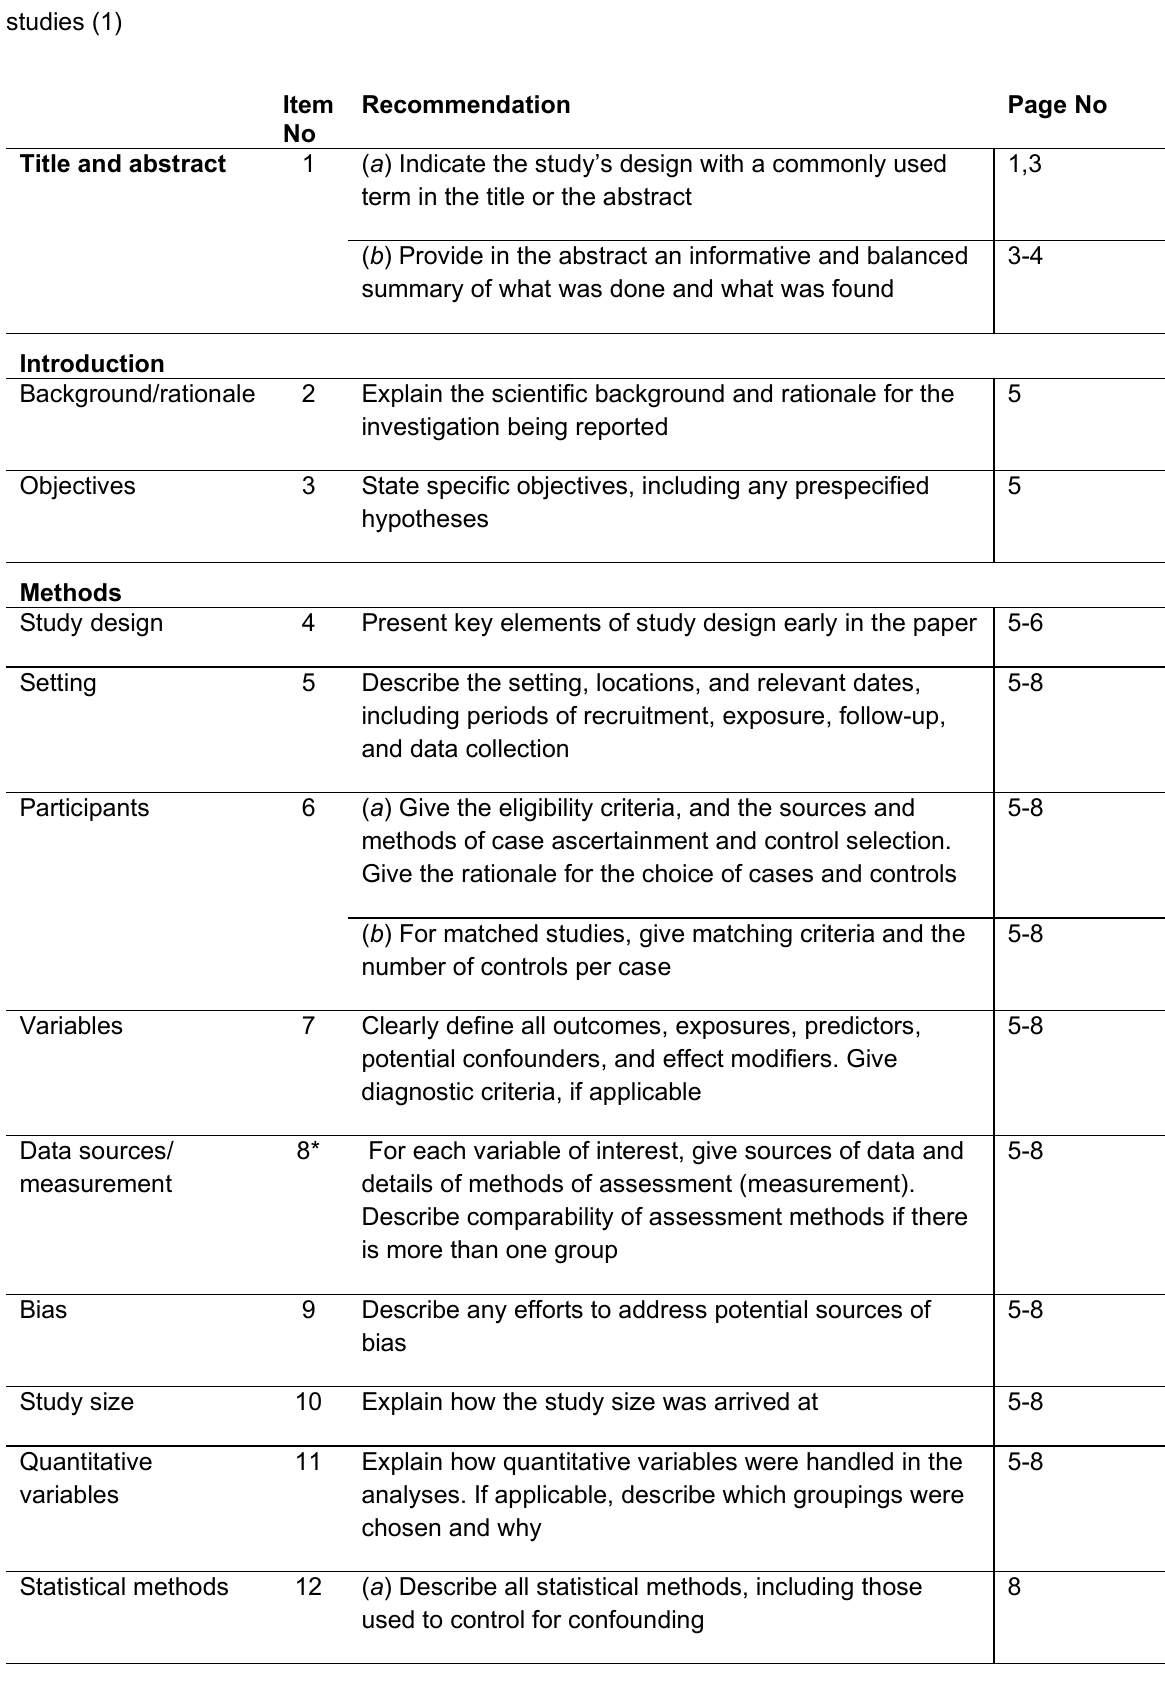
Table S1: STROBE Statement—Checklist of items that should be included in reports of case-control studies (1)